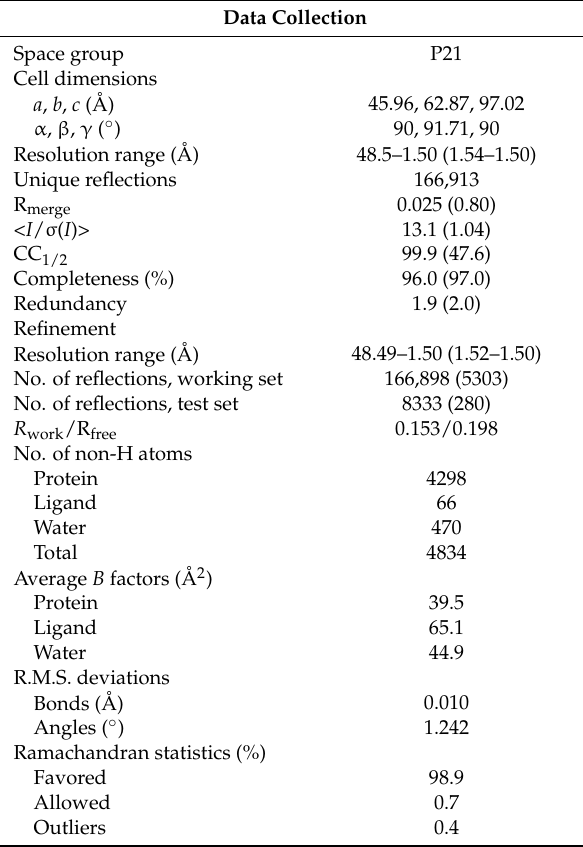
Table 1. Data collection, phasing and refinement statistics 1